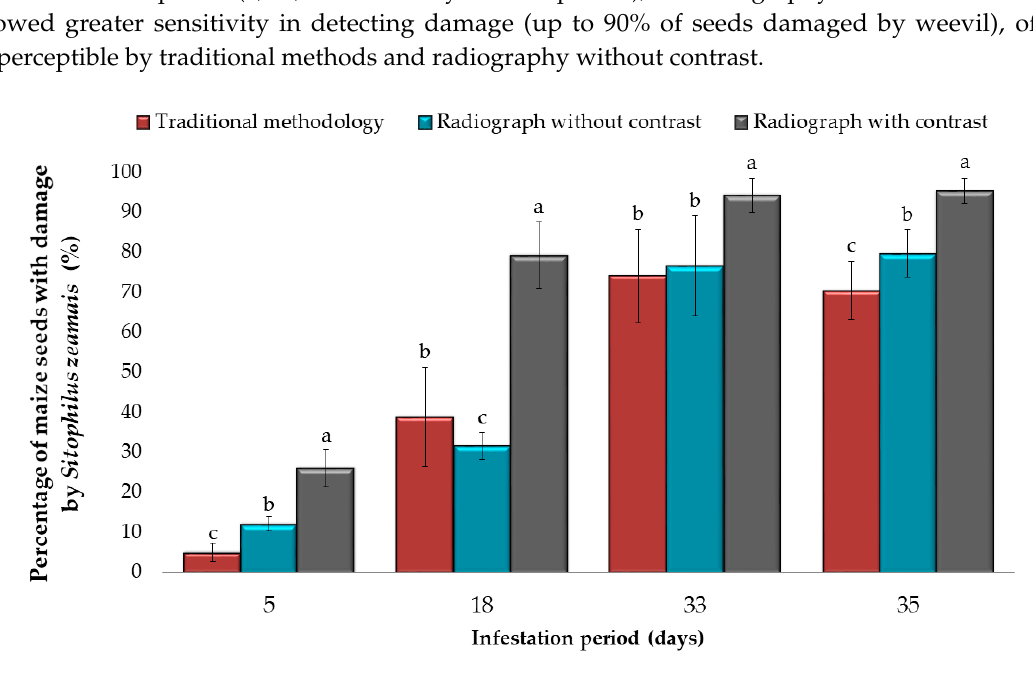
Values within the same line followed by the same letter are not significantly different, Tukey-Kramer ( p < 0.05).